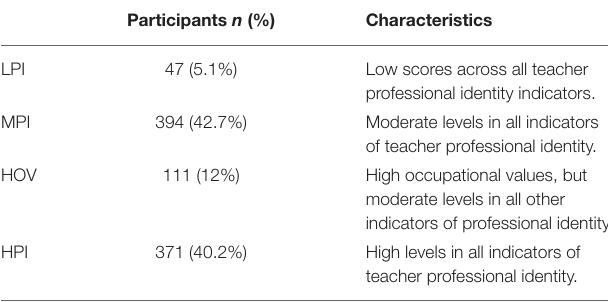
TABLE 3 | Characteristics of the four teacher professional identity groups.